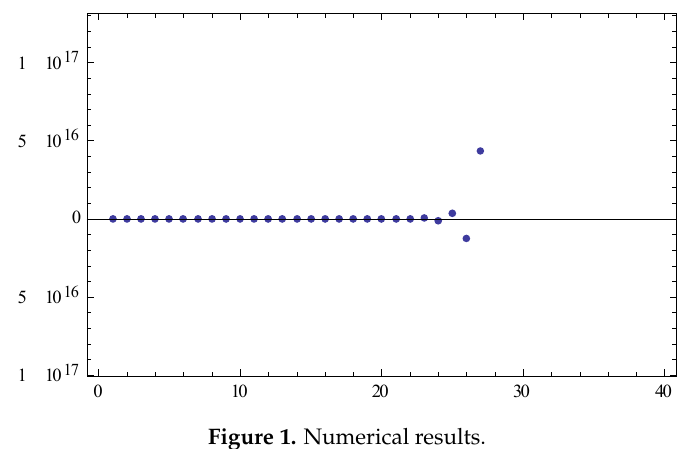
Figure 1. Numerical results.